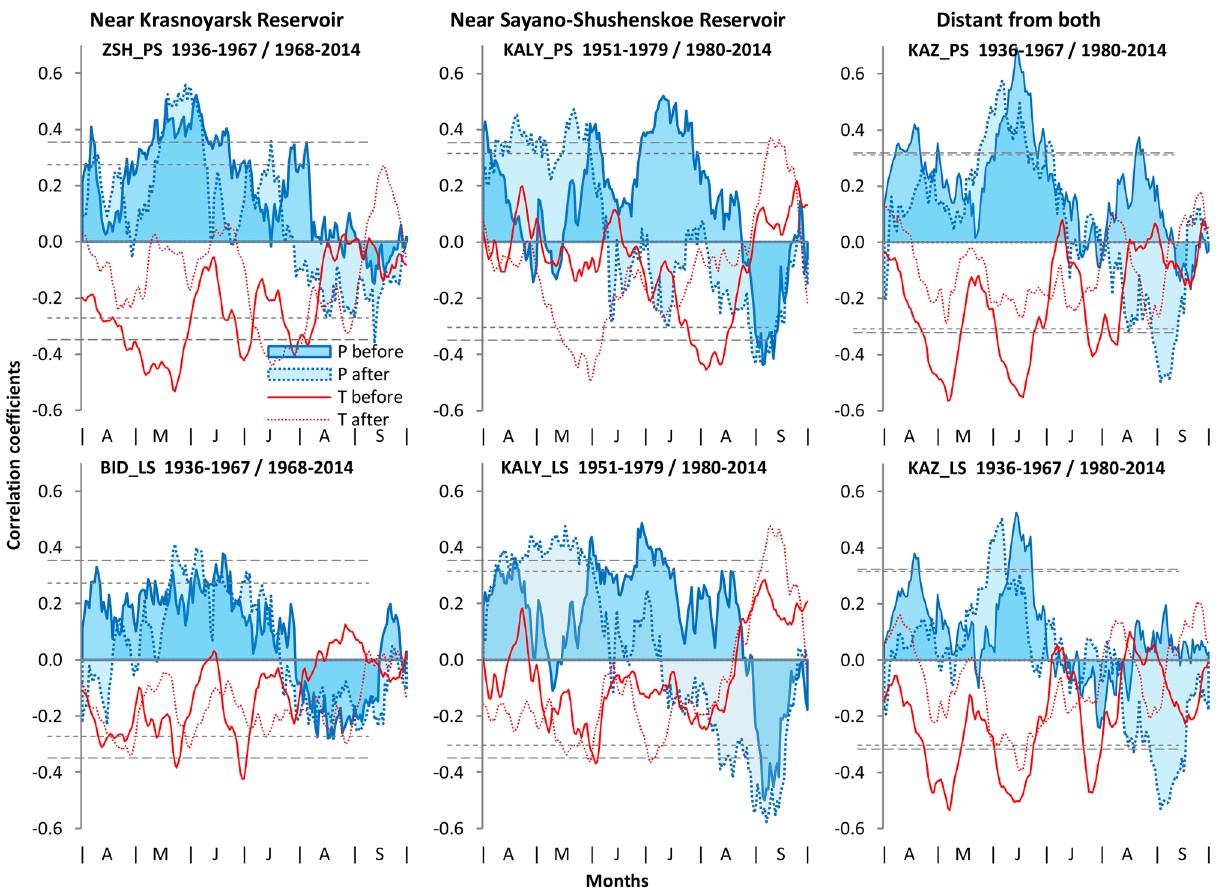
Figure 3. Windowed (21-day) correlations of TRW chronologies with temperature T and precipitation P during vegetative season over sub-periods before and after launching of the turbines in dams on example of 6 chronologies. Correlations plotted at center of 21-day window. Dashed horizontal lines represent significance at p < 0.05 for the first (long dashes) and the second (short dashes)